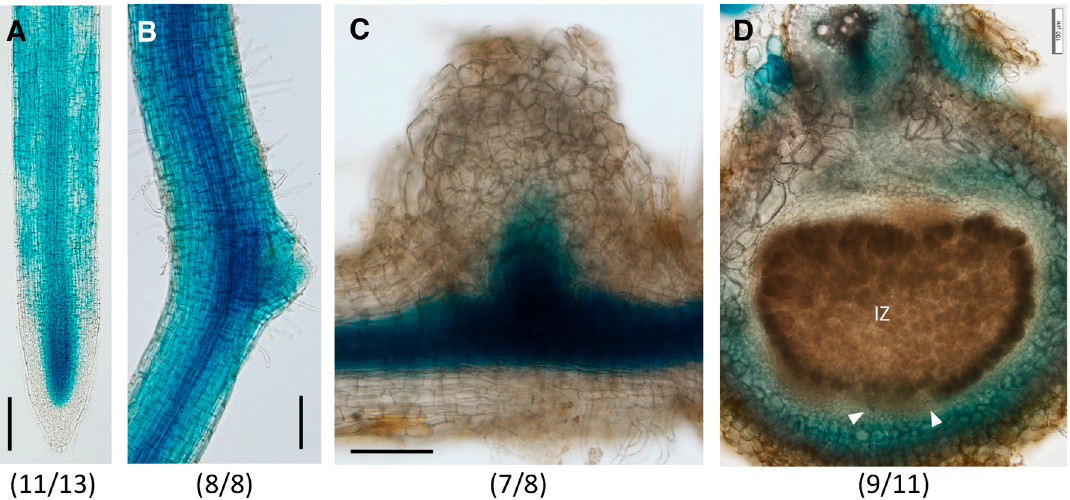
Figure 5. Expression patterns of GmGH3-15p:GUS in soybean roots and nodules. ( A , B ) Expression of GmGH3-14p:GUS in ( A ) root tips, and ( B ) mature root region with an emerging lateral root; ( C , D ) Expression of GmGH3-15p:GUS in ( C ) emerging nodule at 10 dpi and ( E ) mature nodule (transverse section at 17 dpi). IZ–infection zone; Arrowheads indicate nodule vascular bundles. The number of independent transgenic roots/nodules showing the representative staining pattern out of the number of roots/nodules examined is indicated in each panel. Scale bars: 100 μ m.